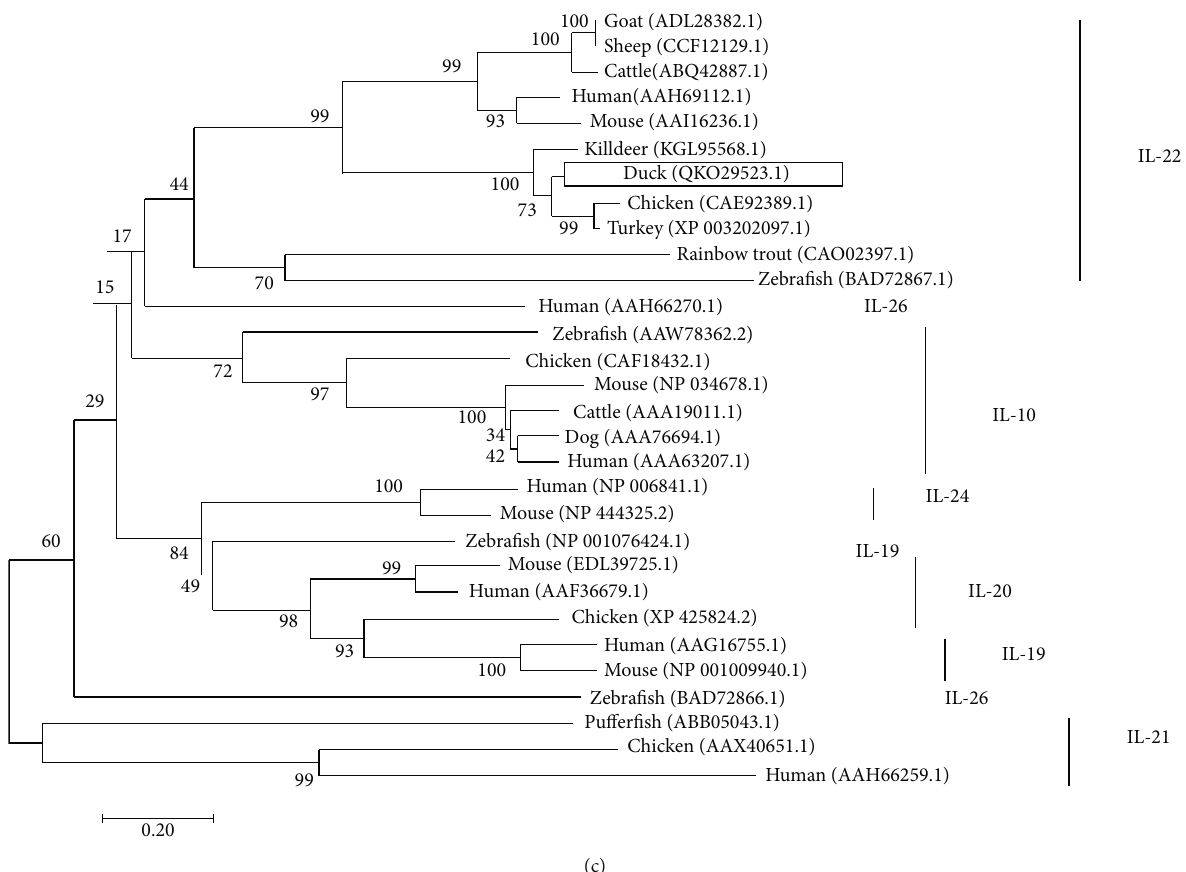
Figure 1: Molecular characterization and genetic analysis of duck IL-22 cDNA. (a) Sequences of nucleotide and deduced amino acid of duck IL-22. The underline indicated the predicted signal peptide region, black boxes indicated the conserved cysteine residues, and white box indicated the putative N- linked glycosylation area. (b) Multiple alignment of amino acid sequence of avian and mammalian IL-22. Clustal Omega software was used for multiple alignments. The identical residues among sequences were indicated with asterisks ( ∗ ). The underline indicated the signal peptide of duck IL-22, white boxes indicated the conserved cysteine residues between species, and the conserved IL-10 family motif is underlined using a dashed line. GenBank accession numbers used in the comparison are written after the species names. (c) Phylogenetic tree indicating the relationships between IL-22 amino acid sequences and other known IL-10 family members. The tree was made using the neighbor-joining method (MEGA version 7 program) and amino acid multiple alignments. The node values indicated percentage bootstrap con fi dence levels obtained from ten thousand replicates. The sequence accession numbers are written after the species name. The white box indicated duck IL-22. Table 2: Duck IL-22 percent identity and similarity with IL-22 sequences of other vertebrates. Duck IL-22 Species Nucleotide Protein Identity GenBank Acc. No. Identity Similarity GenBank Acc. No. Human 55.3 BC069112.1 43.9 Cattle 35.4 EF560596.1 Rainbow trout 35.6